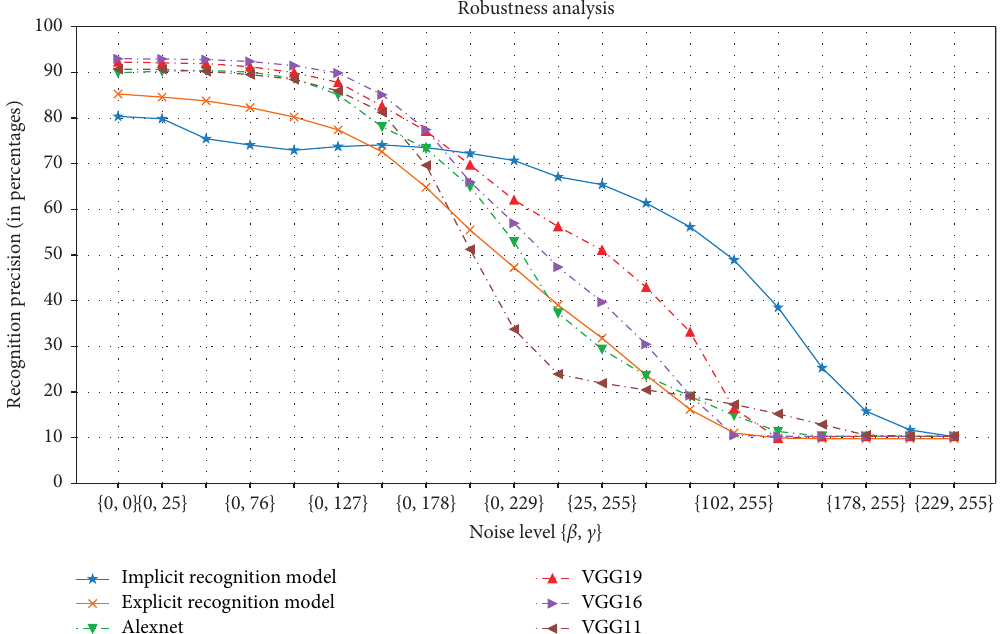
Figure 17: Recognition precision of Implicit Recognition Model, Explicit Recognition Model, Alexnet, and VGG at noise levels {0, 0}, {0, 25}, {0, 51}, {0, 76}, {0, 102}, {0, 127}, {0, 153}, {0, 178}, {0, 204}, {0, 229}, {0, 255}, {25, 255}, {51, 255}, {76, 255}, {102, 255} , {127, 255}, {153, 255}, {178, 255}, {204, 255}, and {229,